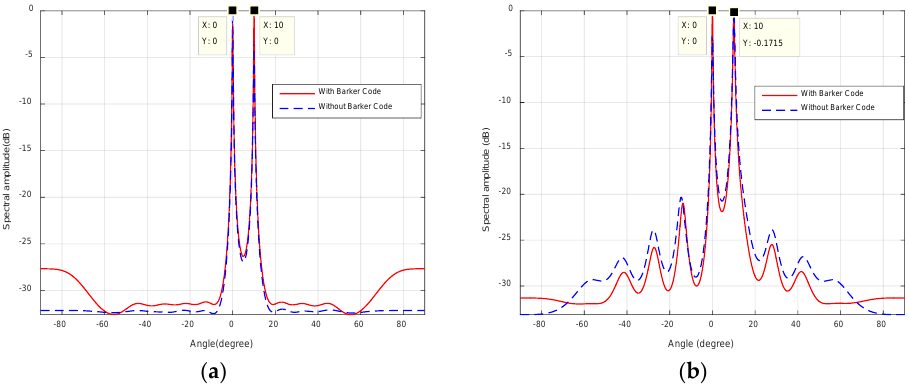
Figure 7. Comparison of the spatial spectral, ( a ) angles in (8) is uniformly distributed in form of sin( θ ); ( b ) angles in (8) is uniformly distributed in range of [ −π/2, π/2).